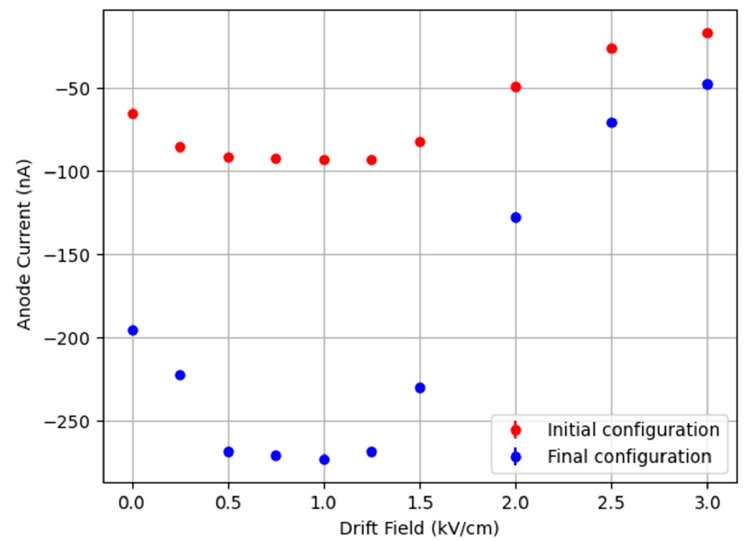
Figure 4. Current at the anode as a function of the drift field strength. Initial configuration (red): transfer field 1 = 3.0 kV/cm; transfer field 2 = 3.0 kV/cm; induction field = 5.0 kV/cm. Final configu- ration (blue): transfer field 1 = 2.0 kV/cm; transfer field 2 = 1.75 kV/cm; induction field = 5.0 kV/cm. A drift field of 1 kV/cm was selected as it yielded the maximum signal. The uncertainties are smaller than the data points.